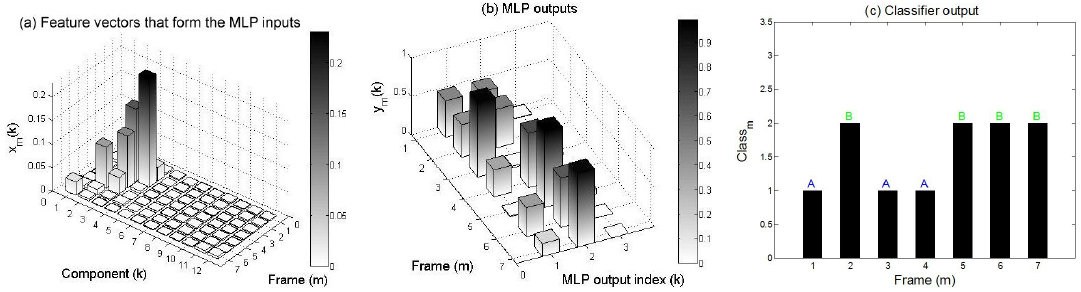
Figure 13. ( a ) feature vectors based on STFT extracted from a B call; ( b ) MLP outputs; and ( c ) class recognizer output. During the first frames, the B call is confounded with A.